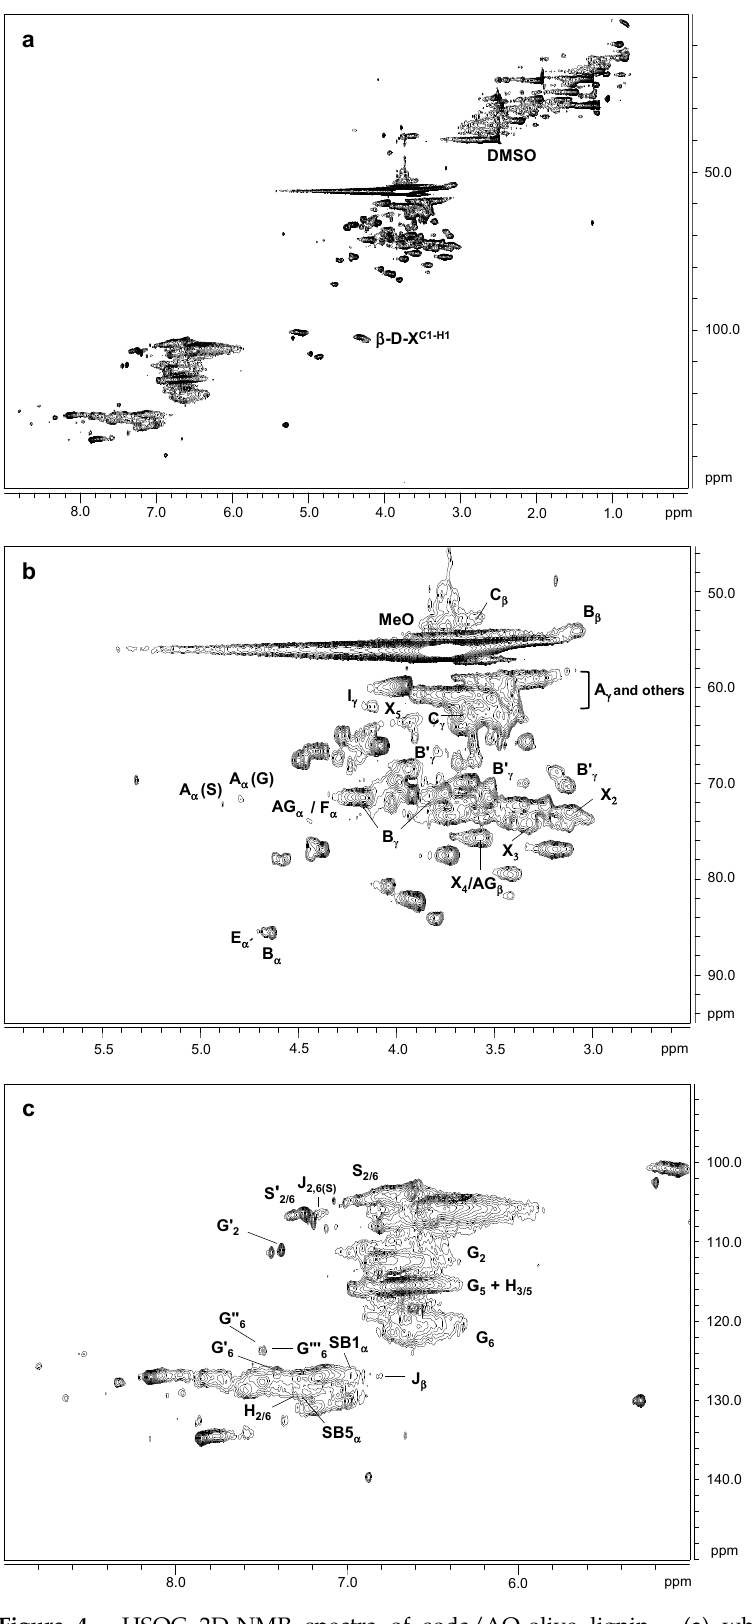
Figure 4. HSQC 2D-NMR spectra of soda/AQ-olive lignin. ( a ) whole spectrum, δ C / δ H 0.0–150.0/0.0–9.0; ( b ) aliphatic oxygenated region, δ C / δ H 45.0–95.0/2.5–6.0 ppm; ( c ) aromatic region, δ C / δ H 90.0– 150.0/5.0–9.0 ppm.